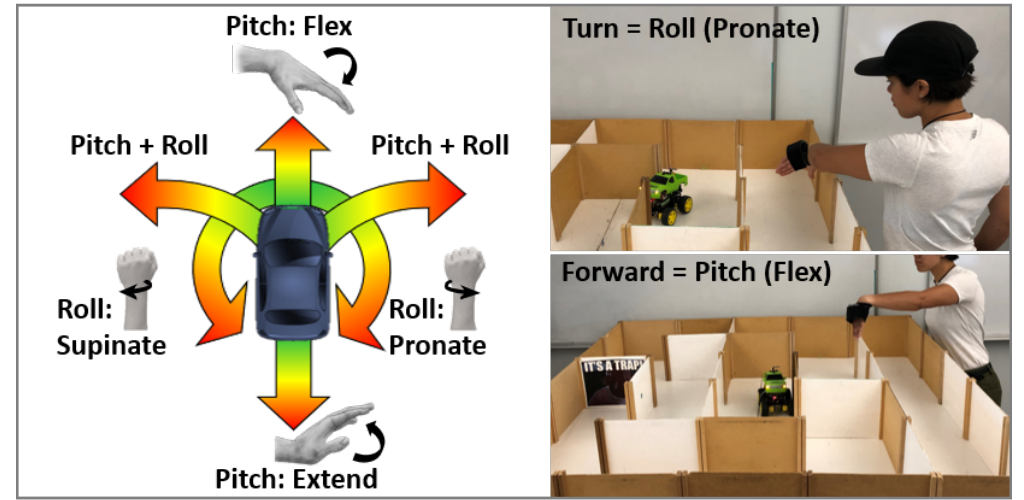
Figure 2. Proportional car control for left-handed operations. (Left) Mapping between user gestures and car movements. Wrist flexion-extension (pitch) produces forward/backward motion; pronation-supination (roll) produces on-the-spot turning; and flexion combined with roll produces gradual arching turns. (Right) Typical hand gestures for translational and rotational car control during a testing session.